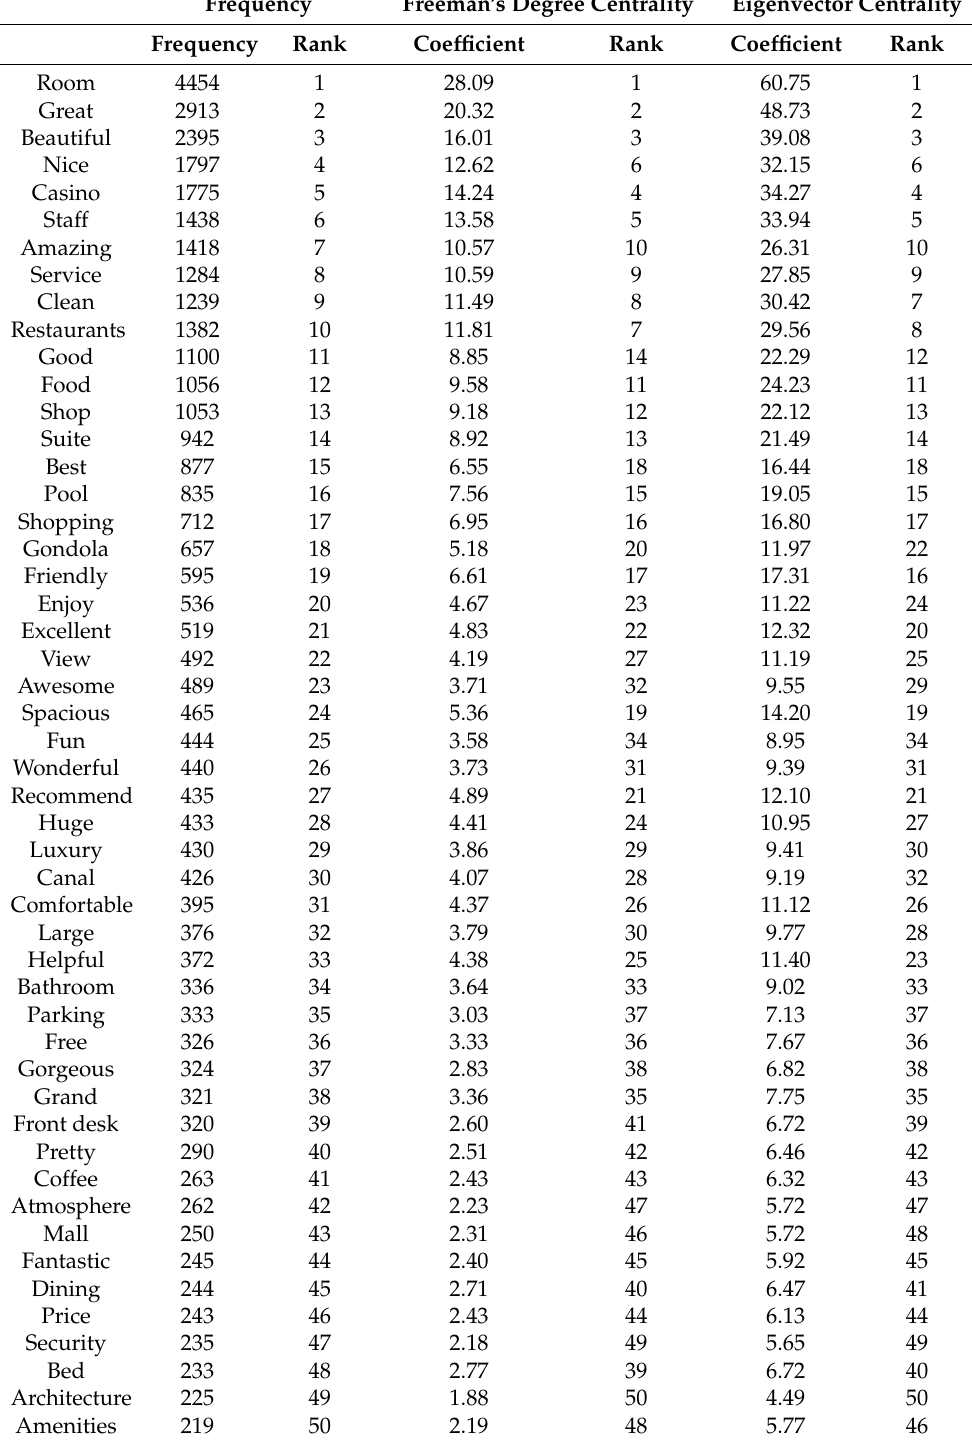
Table 2. Comparison of keywords frequency and centrality (The Venetian in Las Vegas). Frequency Freeman’s Degree Centrality Eigenvector Centrality Frequency Rank